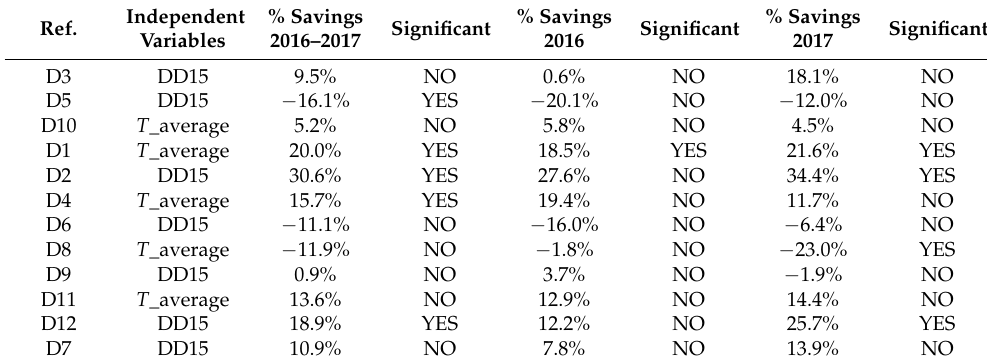
Table 13. Simple linear regression model.